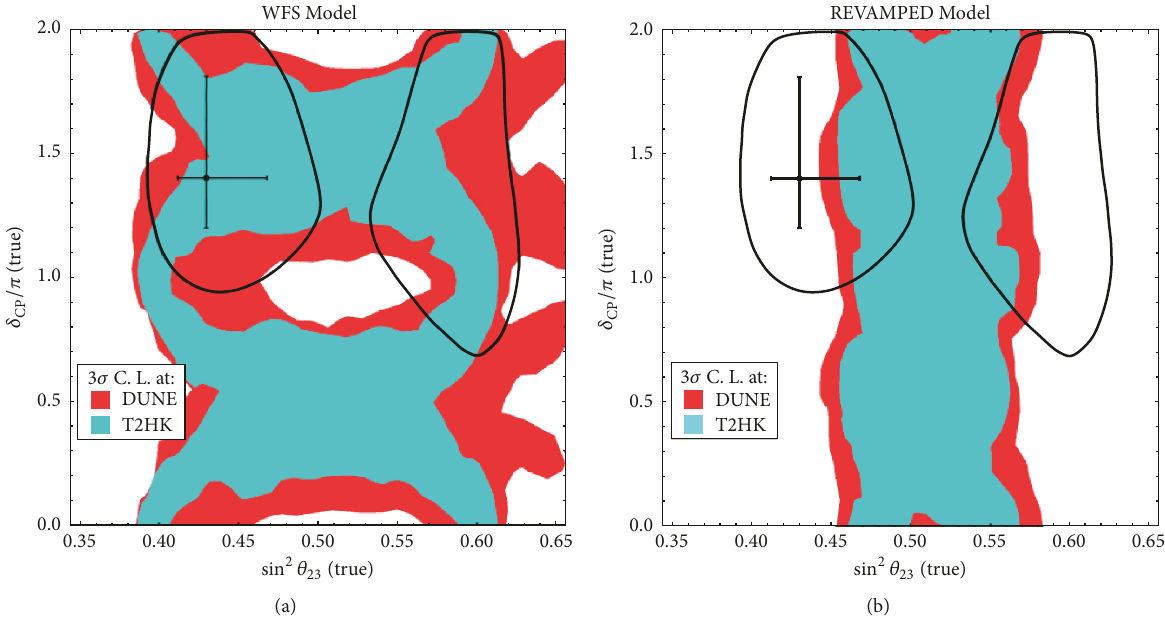
Figure 4: Expected sensitivity regions at which DUNE (Red) or T2HK (Cyan) would not exclude the WFS model (a) and the Revamped BMV model (b) at 3𝜎 confidence level. The black contours correspond to 90% CL of current global fit